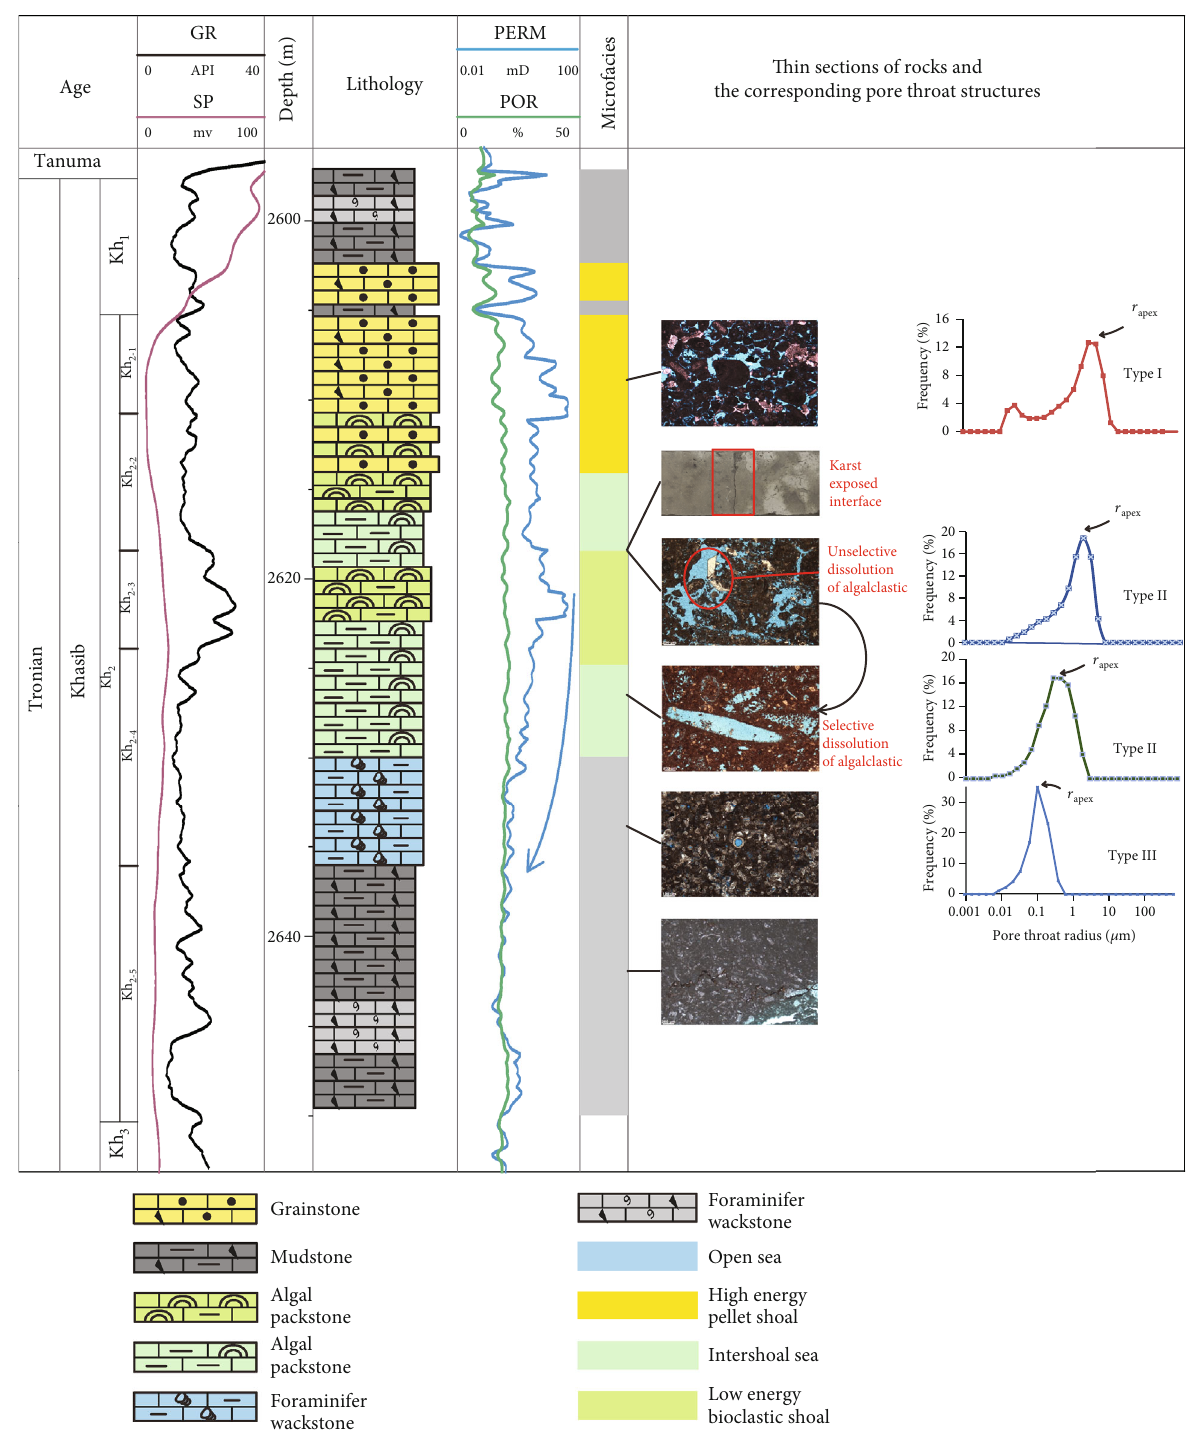
Figure 15: Comprehensive diagram of lithology and pore